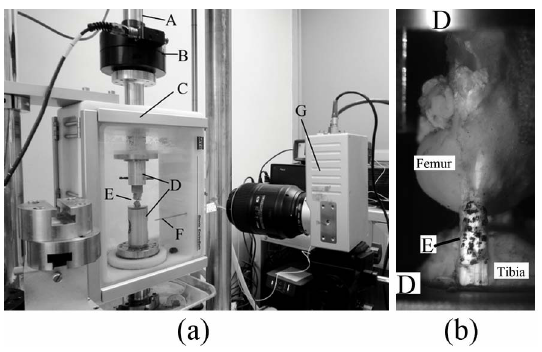
Figure 2. Experimental apparatus used to measure the mechanical behavior of the mid-substance specimen of rabbit MCL. The tensile load was applied by an actuator (A), and recorded by a load cell (B) in the MTS testing machine. Two clamps (D) were adjusted to hold the bone-MCL-bone sample (E) vertically to ensure that the tensile load was applied along the longitudinal axis of the mid- substance specimen of the ligament. All the tests were performed in a bath chamber (C) at physiological temperature (controlled by a temperature sensor (F)) and humidity. The displacements of ink speckles on the mid-substance specimen were measured by a camera (G) and used to calculate the tensile strain by a custom-written MATLAB